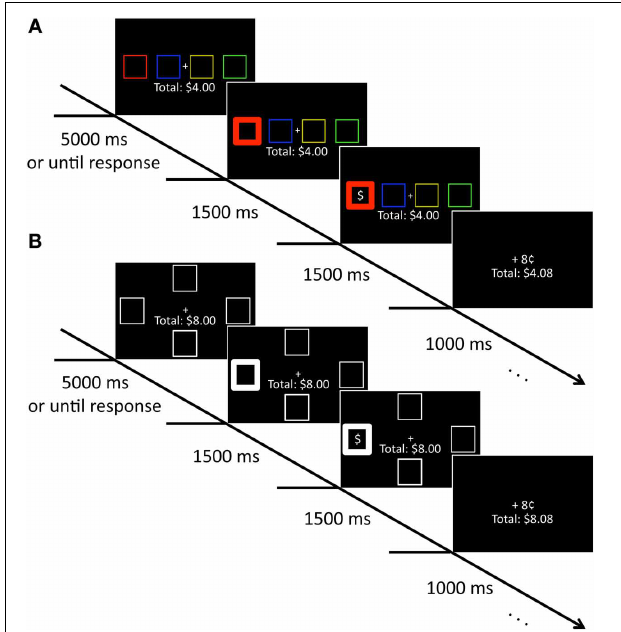
FIGURE 1 | Sequence of events for training and test phase trials. (A) During training, participants selected a colored square to uncover a hidden reward. Participants accumulated money for each reward-containing square they selected. (B) During test, participants selected a square based on location. As in the training phase, they accumulated money for selecting a square containing a hidden reward.